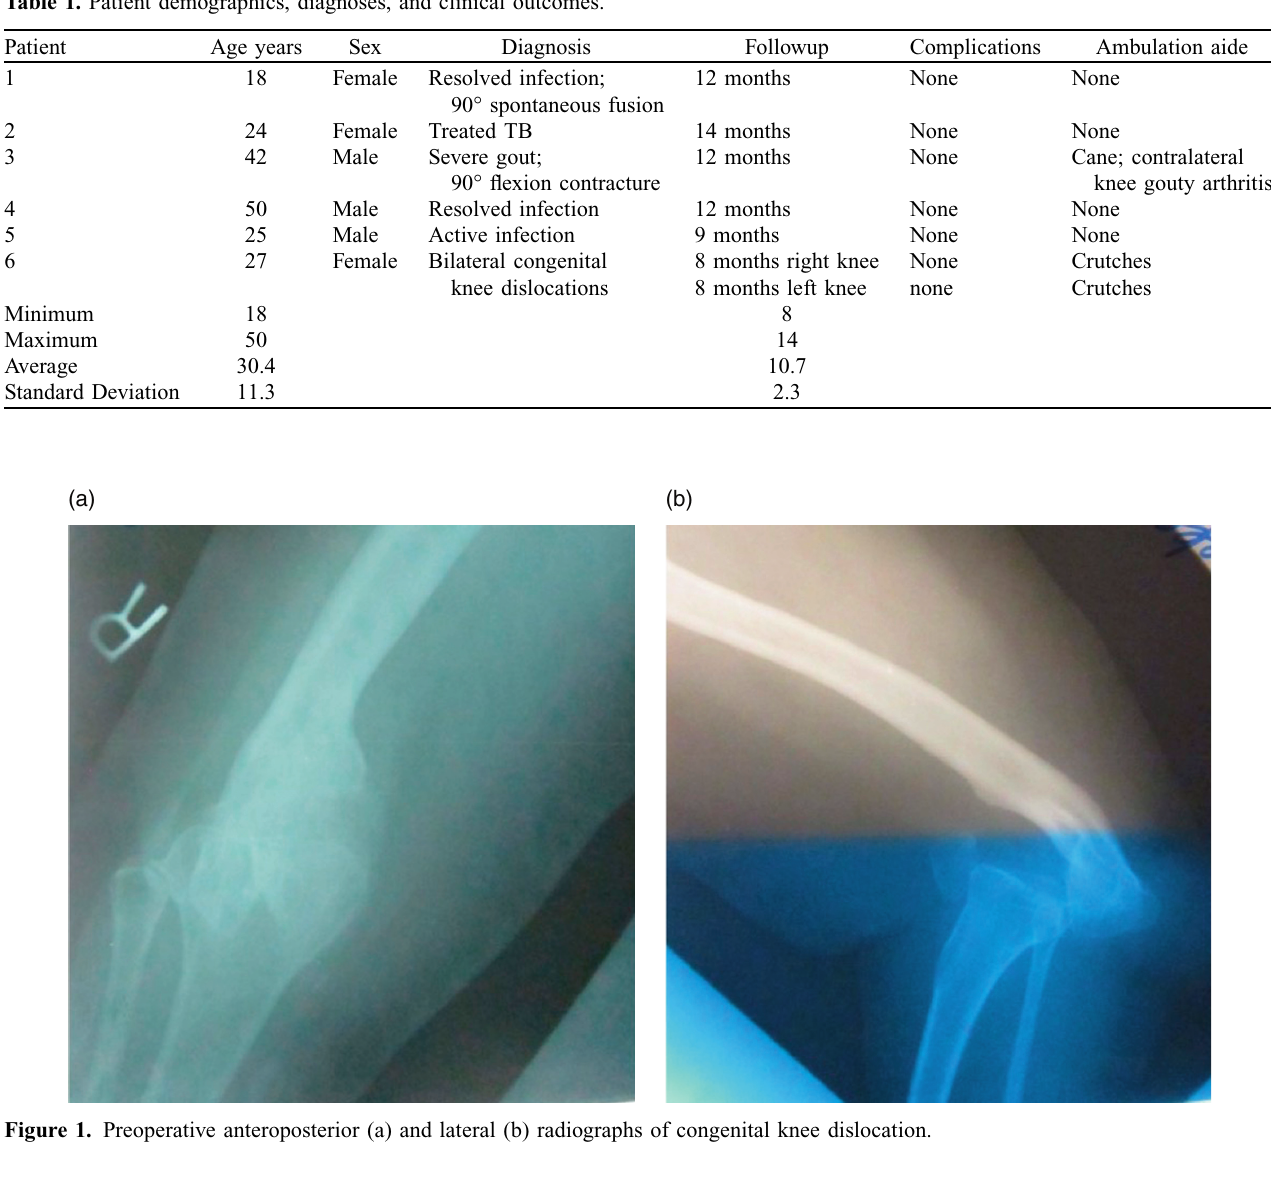
Table 1. Patient demographics, diagnoses, and clinical outcomes.